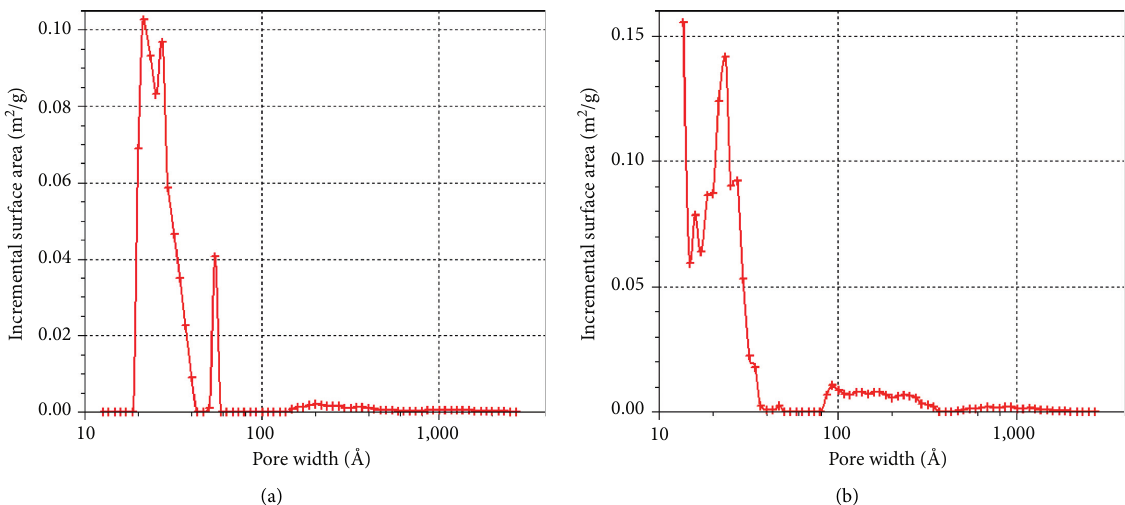
Figure 4: Relationship between the specific surface area increments and the pore diameters of the No. 6 coal seam (˚A is 10 − 1 nm): (a) hard coal; (b) soft coal.